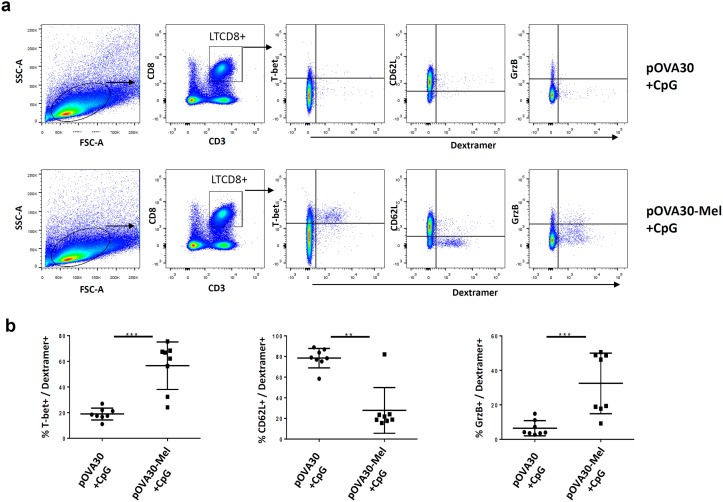
Phenotype of SIINFELKL-specific T-cells in mice immunized on days 0 and 14 with [pOVA30 + CpG] or [pOVA30-melanin + CpG].(a) gating strategy and representative results (in one mouse) for T-Bet, CD62L and granzyme expression. (b) mean ± SD expression of T-bet, CD62L and granzyme within the CD8+dextramer+ population (n = 8 mice/group, with pooled data from two different experiments of 4 mice each). ** p<0,01; ***p<0,001.